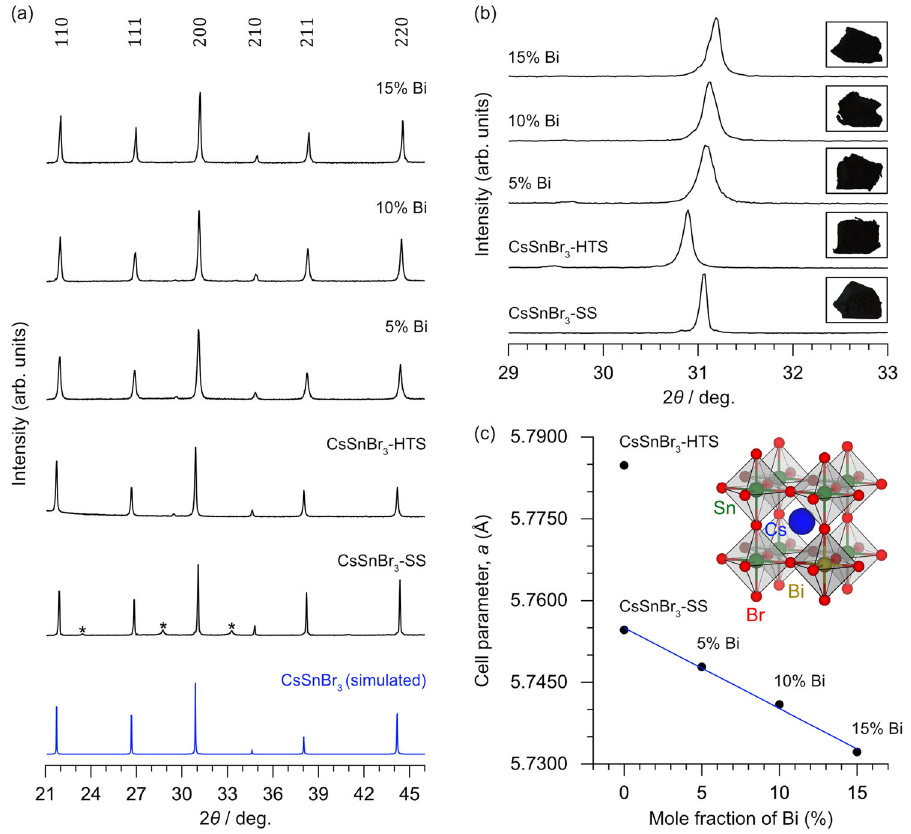
Fig. 1 Long-range structure of CsSnBr 3 and derivatives. a Powder XRD patterns for CsSnBr 3 and Bi-substituted compounds. Trace secondary phases (*, Cs 2 SnBr 6 ). b Comparison of 200 peaks showing shift to higher angles with greater Bi substitution (inset displays the colour of as synthesized compounds). c Evolution of cubic cell parameter a with Bi substitution. Table 1 Nominal compositions, EDX analyses, and re fi ned cubic cell parameters for all